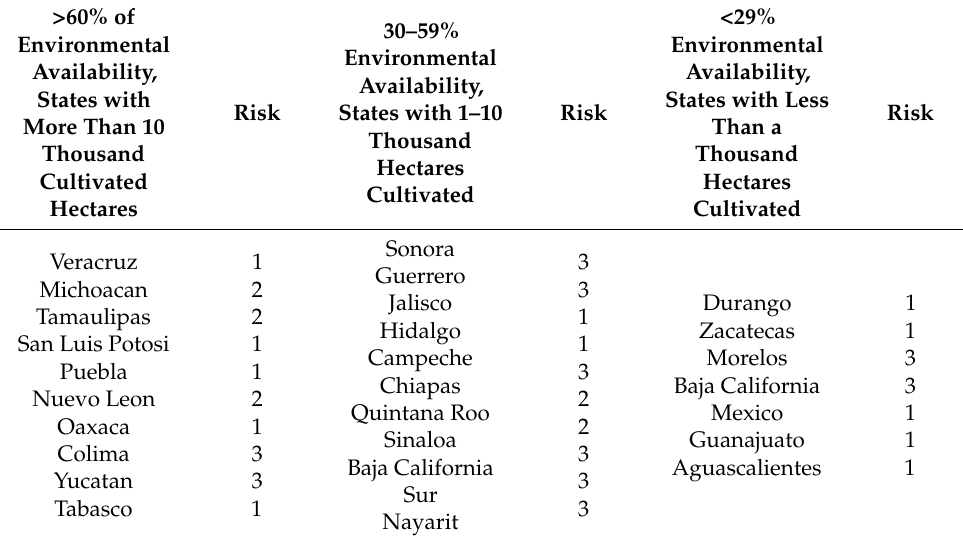
Figure 2. Environmental suitability of the African citrus psyllid, Trioza erytreae (Hemiptera: Triozidae) in Mexico, according to division states. White= areas without environmental suitability; red= areas with environmental suitability. State identifications: (1) Aguascalientes, (2) Baja California, (3) Baja California Sur, (4) Campeche, (5) Coahuila, (6) Colima, (7) Chiapas, (8) Chihuahua, (9) Ciudad de Mexico, (10) Durango, (11) Guanajuato, (12) Guerrero, (13) Hidalgo, (14) Jalisco, (15) Estado de Mexico, (16) Michoacan, (17) Morelos, (18) Nayarit, (19) Nuevo Leon, (20) Oaxaca, (21) Puebla, (22) Queretaro, (23) Quintana Roo, (24) San Luis Potosi, (25) Sinaloa, (26) Sonora, (27) Tabasco, (28) Tamaulipas, (29) Tlaxcala, (30) Veracruz, (31) Yucatan, and (32) Zacatecas. Table 3. Level of risk of Trioza erytreae (Hemiptera: Triozidae) invasion of 27 citrus-producing states in Mexico, according to the percentage of the surface where environmental availability is